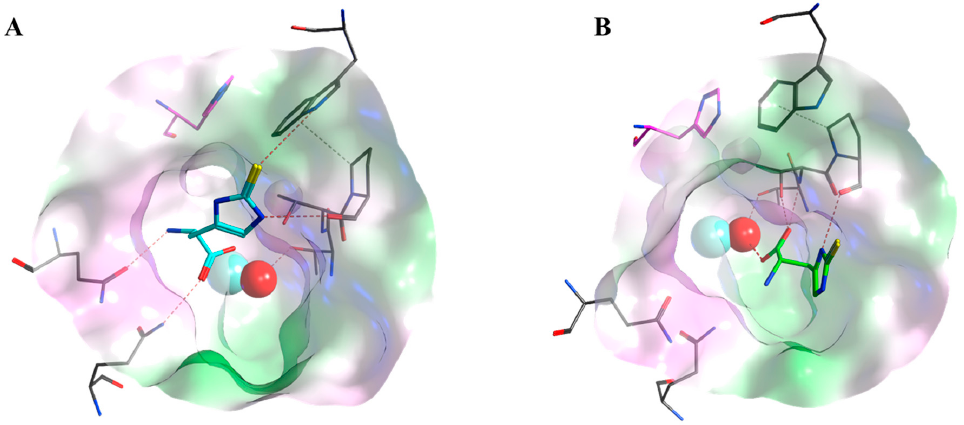
Figure 2. Two different docked poses ( A , B ) of L -(+)-ergothioneine ( 1 ) in the active site of hCA VII. The proton shuttle His66 is shown in magenta.